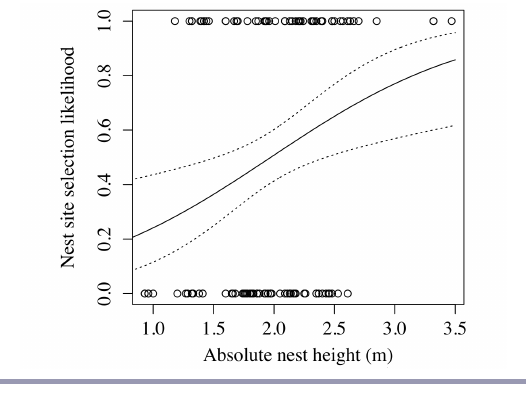
Fig. 2 . Prothonotary Warblers ( Protonotaria citrea ) nesting in natural cavities in White River National